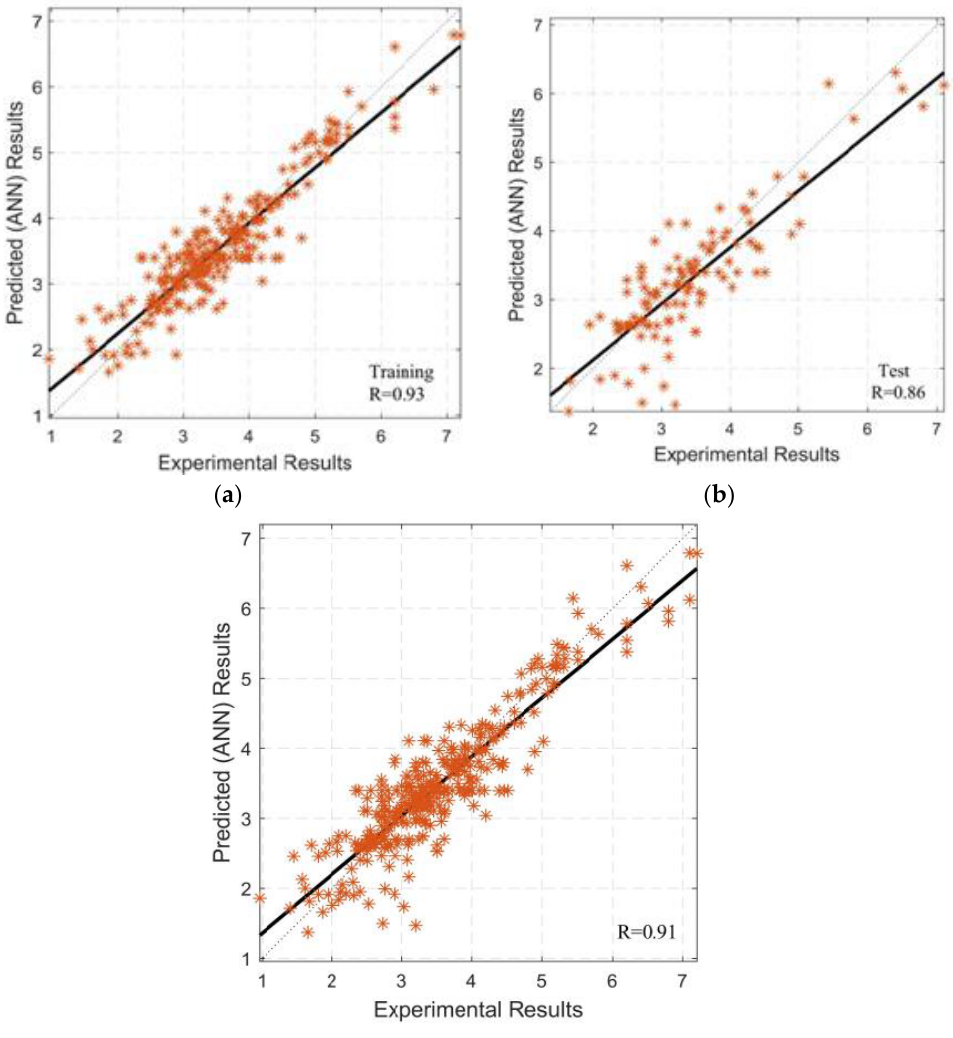
Figure 10. BR model error histogram.